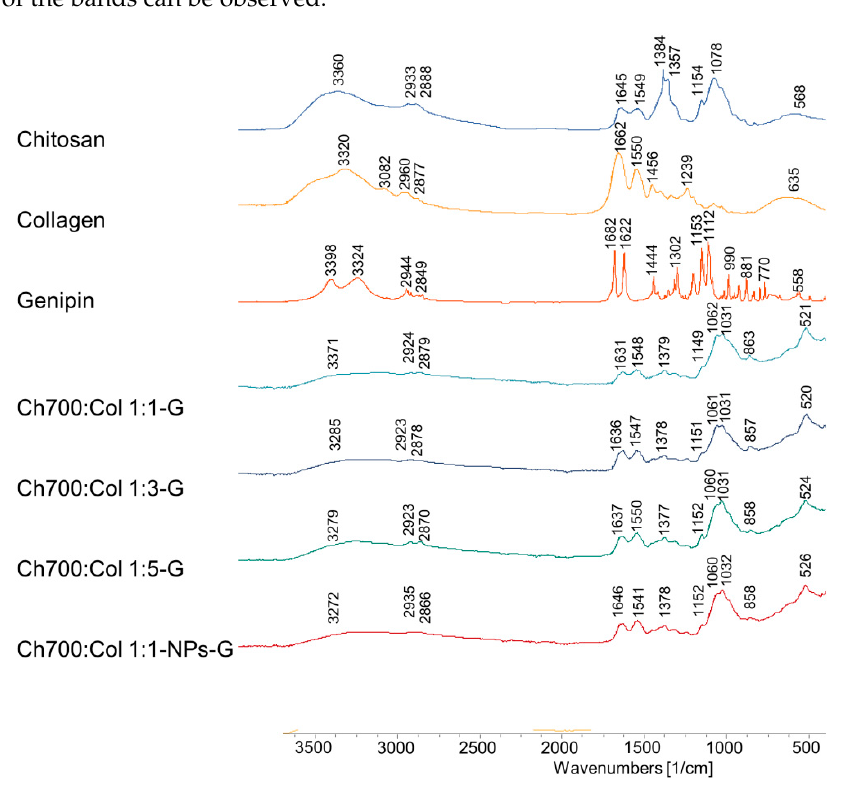
Figure 3. FTIR spectra of Chi, Col, G, Ch700:Col 1:1-G, Ch700:Col 1:3-G, Ch700:Col 1:5-G and Ch700:Col 1:1-NPs-G.